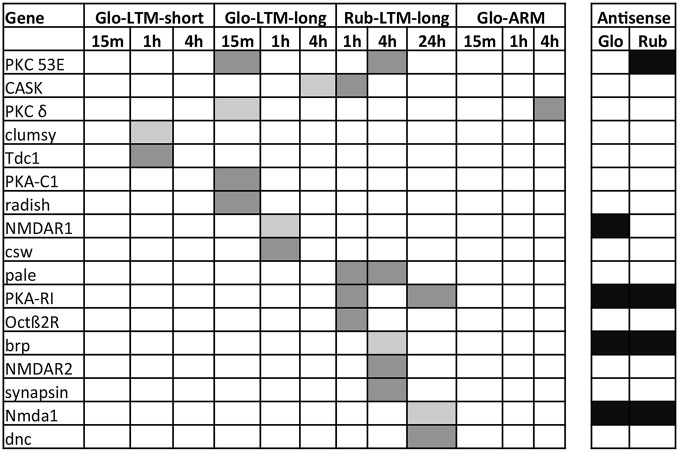
Expression of the DE protein-coding genes involved in memory formation from literature at each time point after conditioning in all four Cotesia conditioning types. Upregulated transcripts are indicated in light gray, downregulated in dark gray. Genes with antisense transcripts are indicated in black for C. glomerata (Glo) and C. rubecula (Rub).